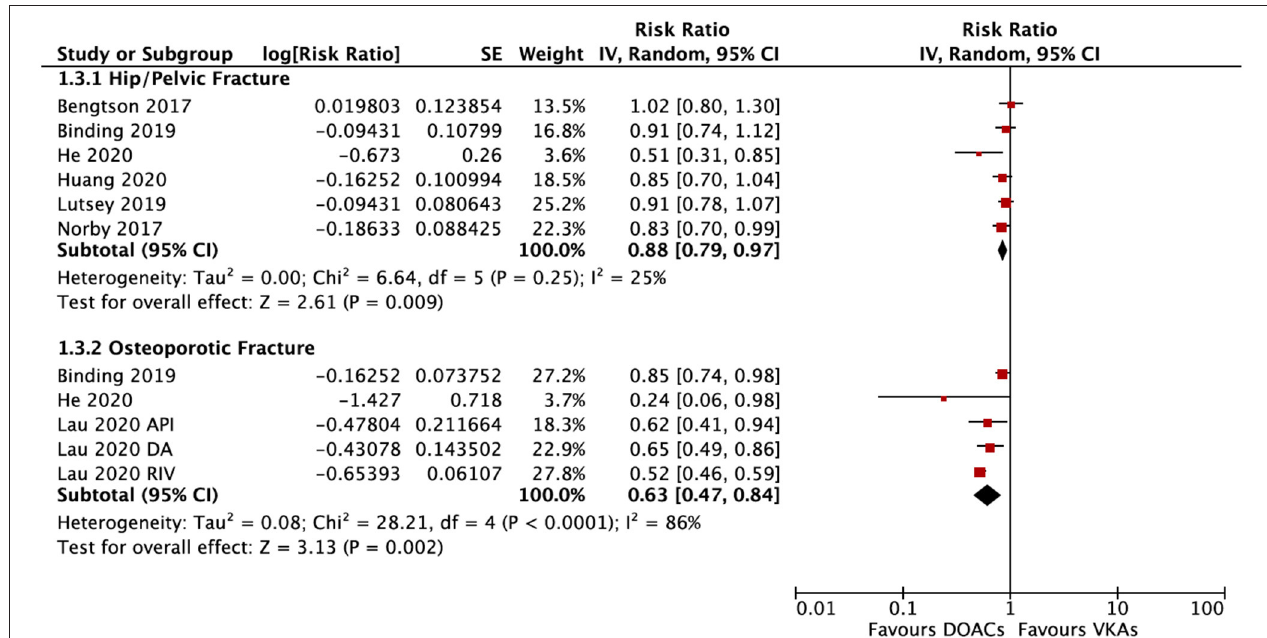
FIGURE 3 | Subgroup analysis based on different positions regarding the risk of fractures of DOACs vs. VKAs in AF patients. AF, atrial fibrillation; DOACs, direct oral anticoagulants; VKAs, vitamin K antagonists; DA, dabigatran; RIV, rivaroxaban; API, apixaban; CI, confidence interval; SE, standard error; IV, inverse of the variance.